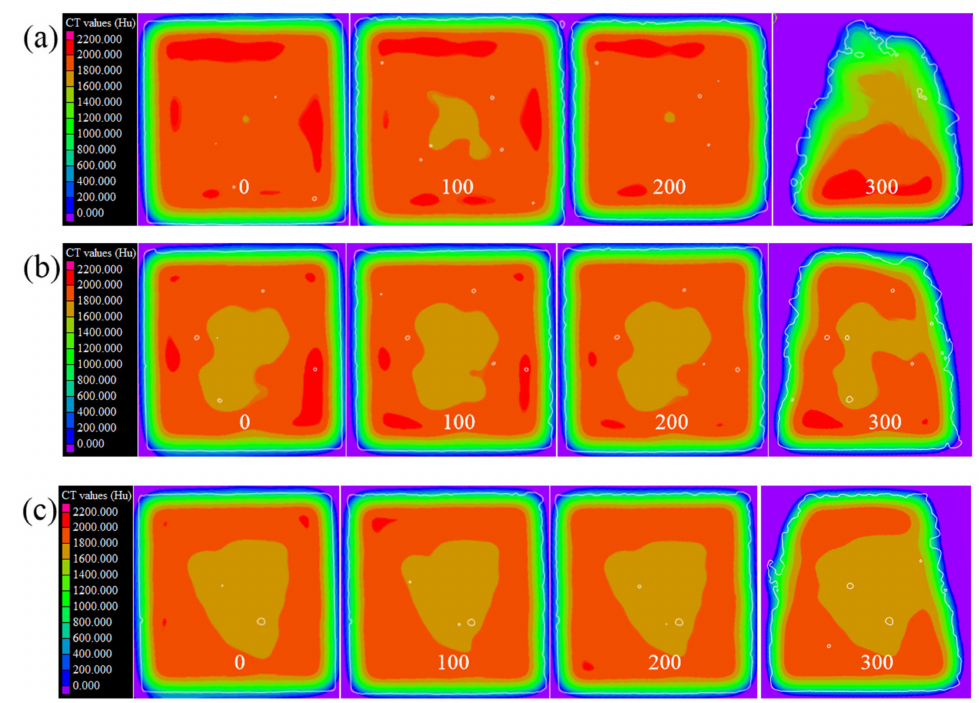
Figure 7. CT value hotspot distributions on concrete sections under salt freezing–thawing cycles: ( a ) section 1; ( b ) section 2; ( c ) section 3.